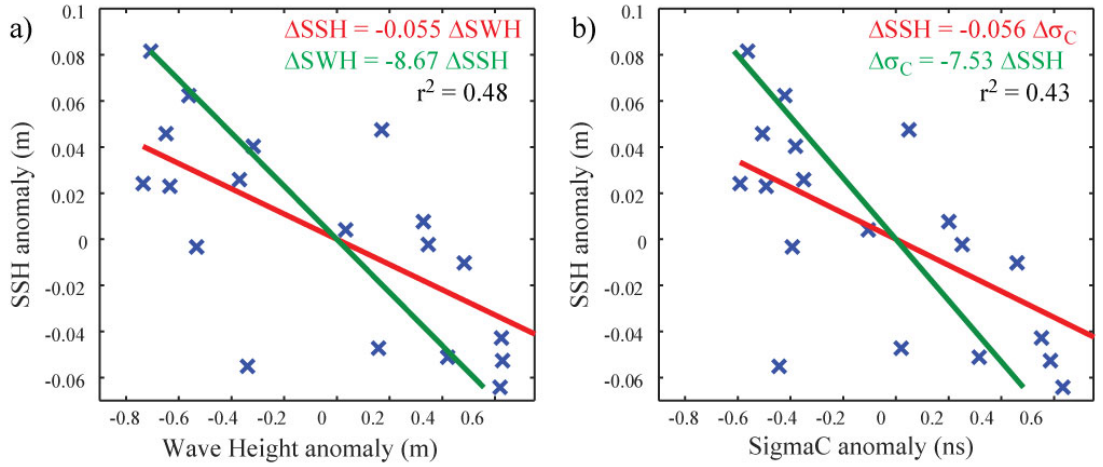
Figure 2. Scatter plot of local anomalies. ( a ) Hs versus ζ . ( b ) σ C versus ζ . The red fitted lines show the regression assuming all error is in the y term, and the green ones assuming all the error is in the x